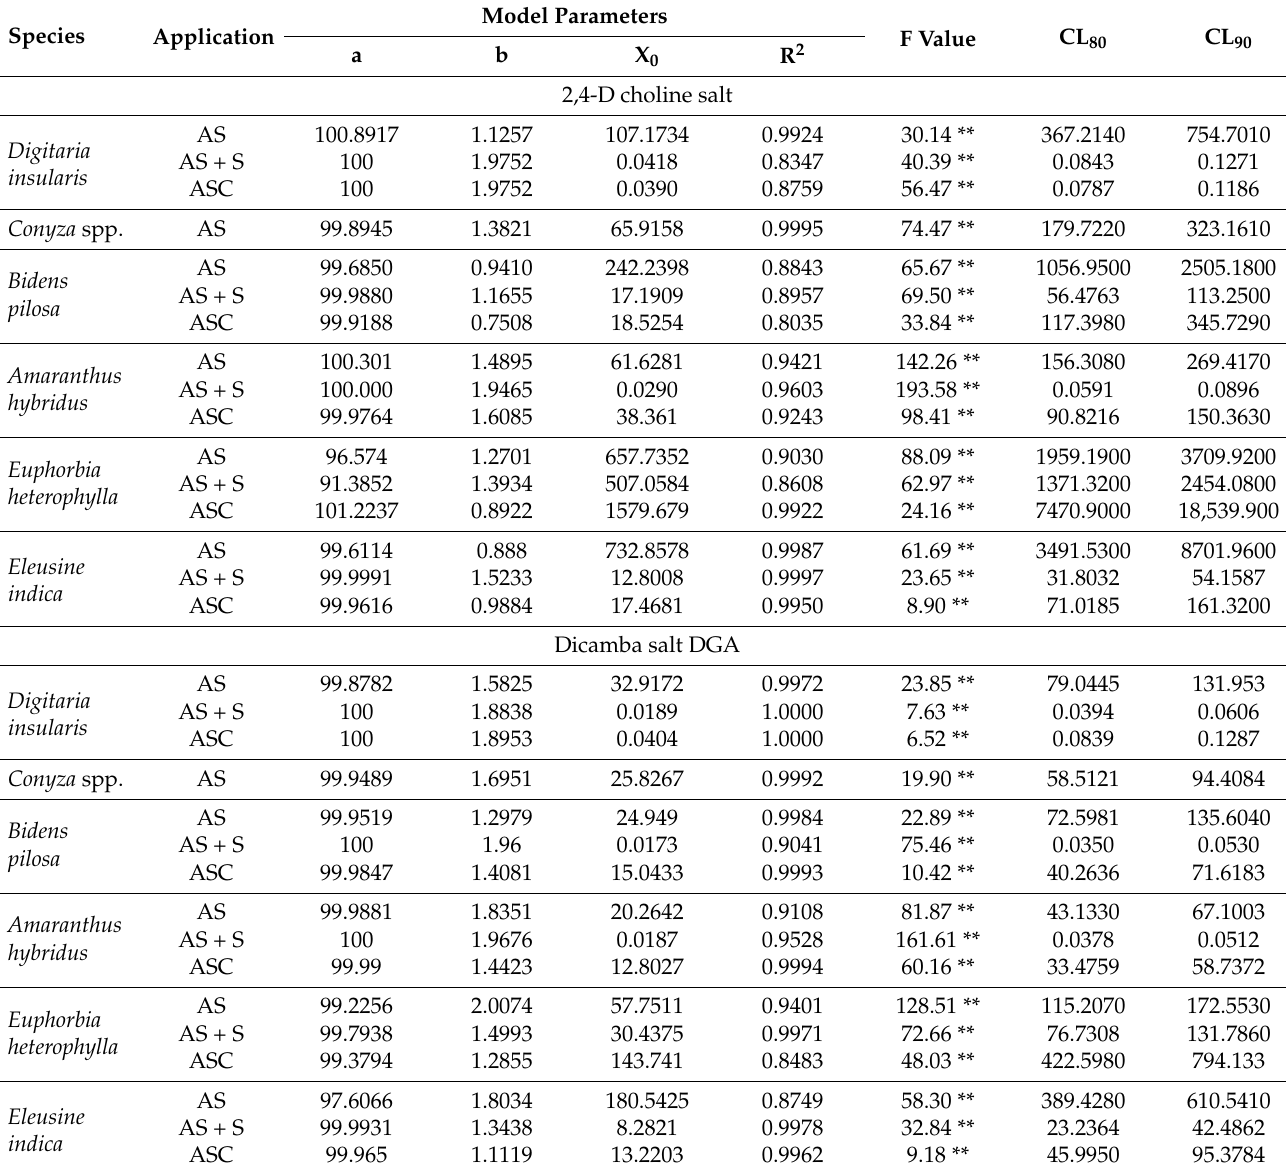
Table 3. Estimates of the parameters in the nonlinear model proposed by Streibig a and CL 80 b and CL 90 c values adjusted for the efficacy of the herbicides 2,4-D choline and dicamba DGA salt for different weeds according to the application